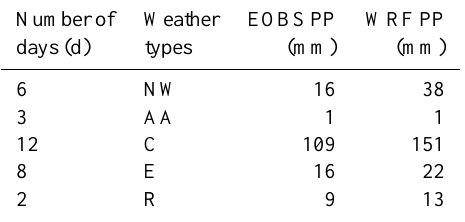
Table 4. Daily weather regime classification for December